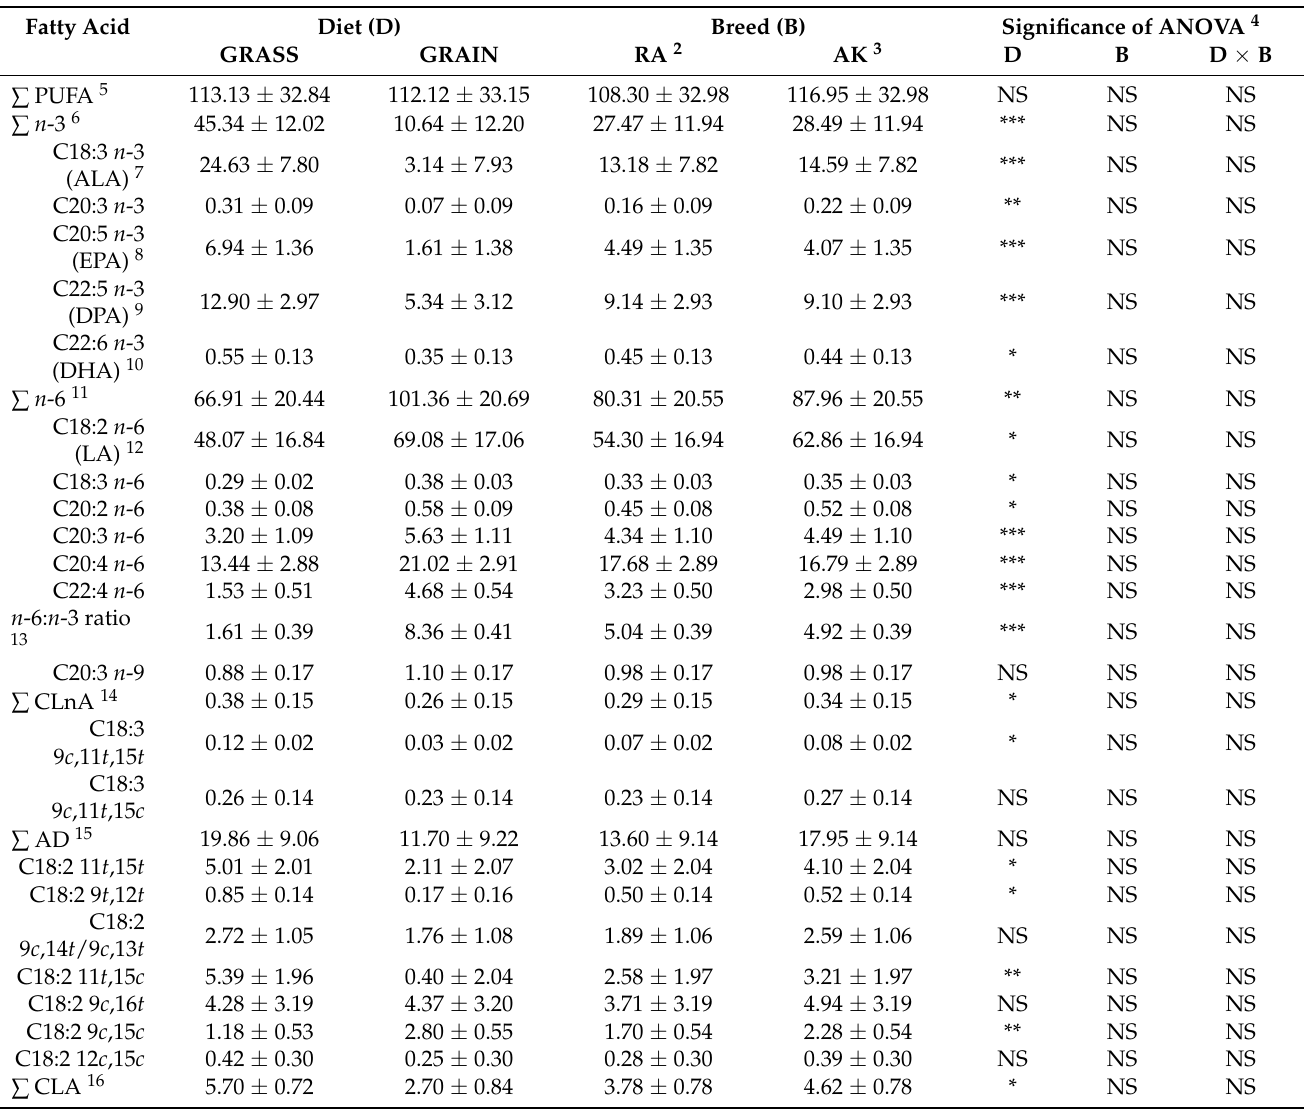
Table 3. Mean concentrations of polyunsaturated fatty acids in beef by diet, breed, and diet × breed interaction (mg per 100 g meat) 1